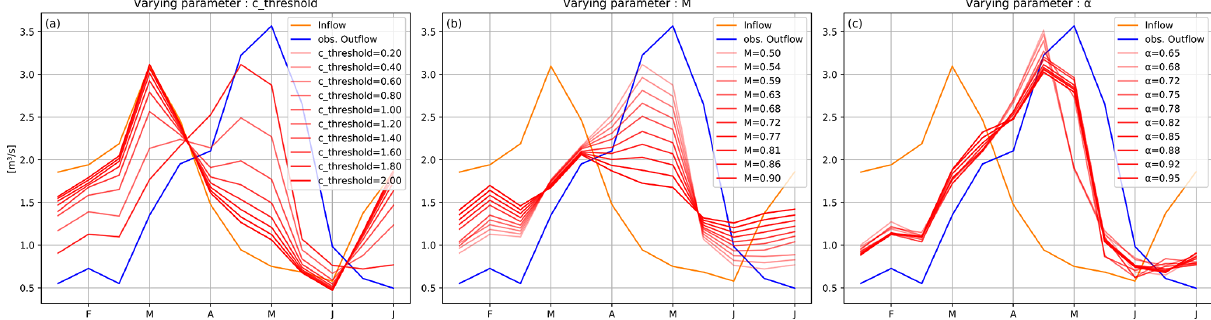
Figure 7. Example of seasonal pattern sensitivity of Gonzalez Lacasa reservoir outflow to three of the DROP model parameters: (a) c threshold , (b) M and (c) α . The remaining parameters were at their default values (see Table